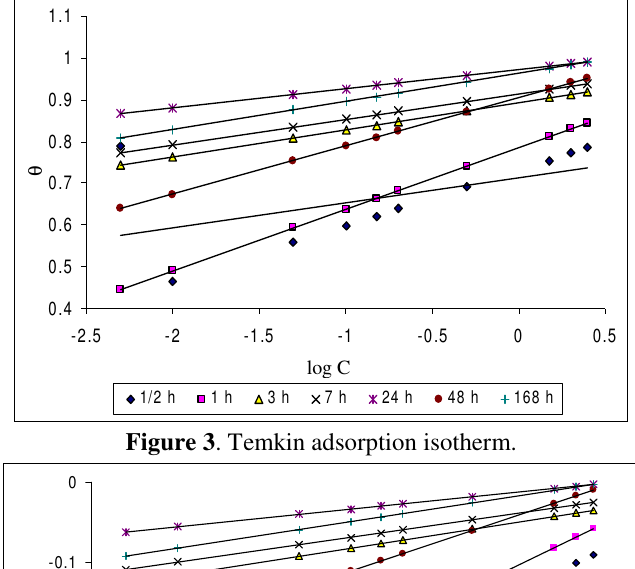
Figure 3 . Temkin adsorption isotherm.